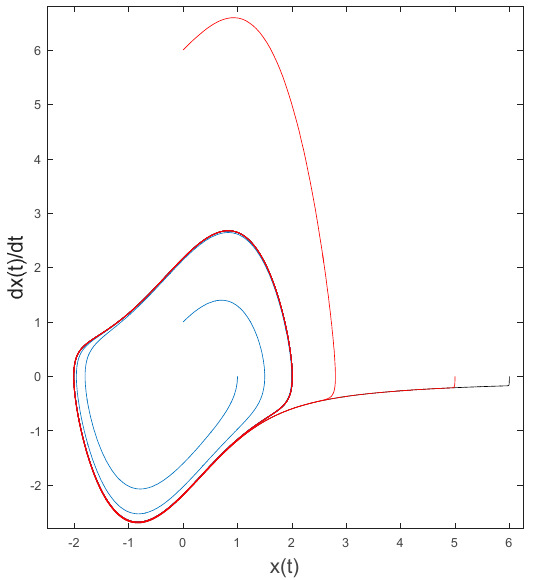
Figure 2 . Forward time-propagation of nonlinear van der Pol Equation (1). Figure 2. Forward time-propagation of nonlinear van der Pol Equation